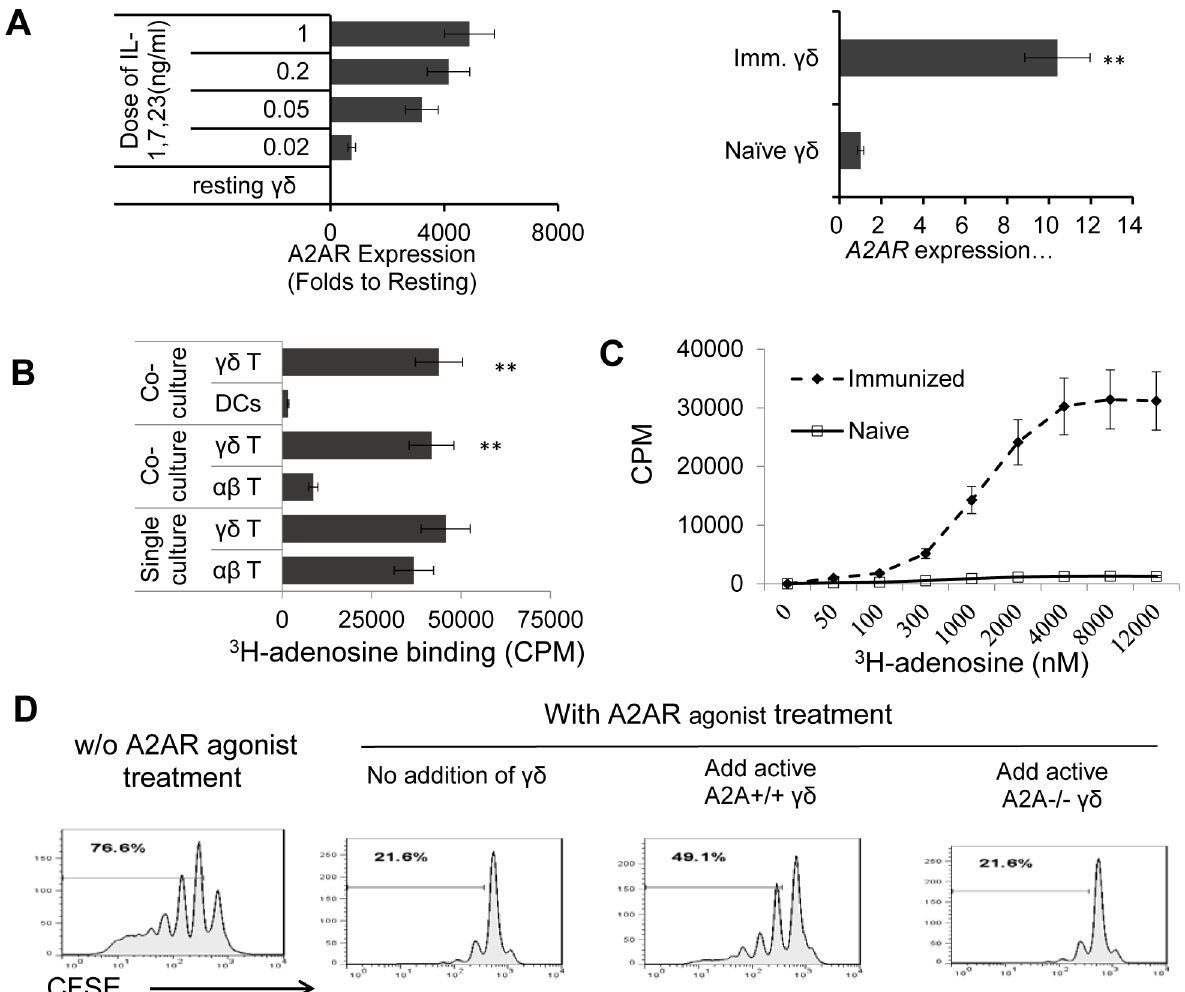
Fig 3. γδ T cells enhance the autoreactive T cell response by competing with the binding of adenosine. A) Activated γδ T cells express an increase of > 1000-times the A2AR but only minimally increased A2BR. Activated γδ T cells and na ï ve γδ T cells were isolated from immunized from na ï ve B6 mice, respectively. The expression of A2AR/A2BR was determined by real-time PCR assay. Real-time RT-PCR analysis of A2AR and A2B transcripts among total RNA isolated from αβ and γδ T cells isolated from na ï ve and IRBP 1-20 -immunized B6 mice before and after in vitro activation. qPCR was performed with Gapdh as the internal reference. Results were represented as 2 - Δ Ct . (cid:3)(cid:3) , p < 0.01. B) Competitive binding test revealed a hierarchical order of adenosine capture by immune cells as γδ T cells >> αβ T cells >> DCs. αβ responder T cells were isolated from IRBP 1-20 -immunized TCR- δ -/- mice. DCs were from 5 d GM-CSF-cultured bone marrow cells. In a 24-well plate the T cells were seeded at 1 x 10 6 / well and DCs at 5 x 10 5 /well. After incubation with1,000 nM H 3 -labeled adenosine for 1 h, the cells were harvested, and cell-bound H 3 -adenosine was counted by liquid scintillation. (cid:3)(cid:3) p < 0.01. C) Comparison of adenosine binding of γδ T cells isolated from naïve and immunized mice γδ T cells from immunized or naïve B6 mice, respectively. 1 x 10 5 /well cells were cultured in 96-well plate for 48h. 0–12,000 nM H 3 -labeled adenosine for 1 h, then the cells were harvested and cell-bound H 3 -adenosine counted by liquid scintillation. D) A2AR +/+ γδ T cells, but not A2AR -/- γδ T cells, possess an enhancing effect, which converted the inhibitory effect to enhancing on the αβ T cell response of an A2AR agonist. αβ and γδ T cells (1 x 10 5 ) were isolated from IRBP 1-20 -immunized TCR- δ -/- mice. The responder αβ T cells were labeled with CFSE and incubated for 5 d with immunizing peptide in the presence of APCs alone (A) or in the presence of the A2AR +/+ or A2AR -/- γδ T cells (B), in the absence or presence of an A2AR agonist, and with or without an addition of A2AR +/+ γδ T cells. The results shown are representative of three